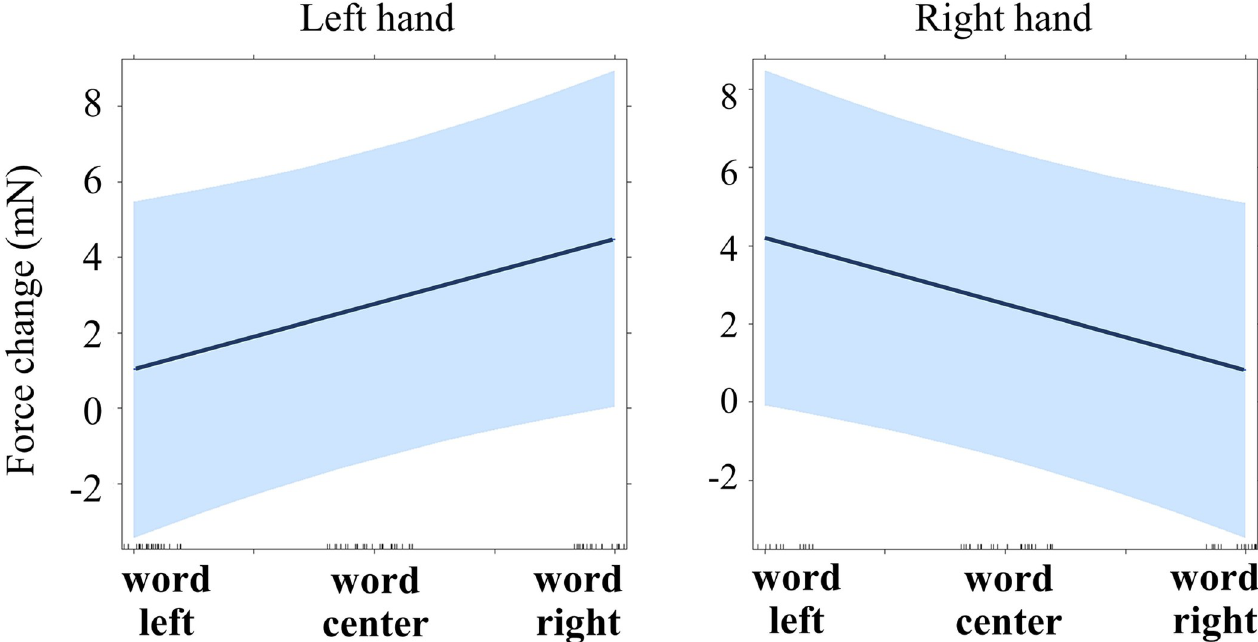
Fig 11. Regression lines for the main effect of word semantics on force (Experiment 3, time window 250–300 ms). See main text for details (Models 3.2 and 3.3).